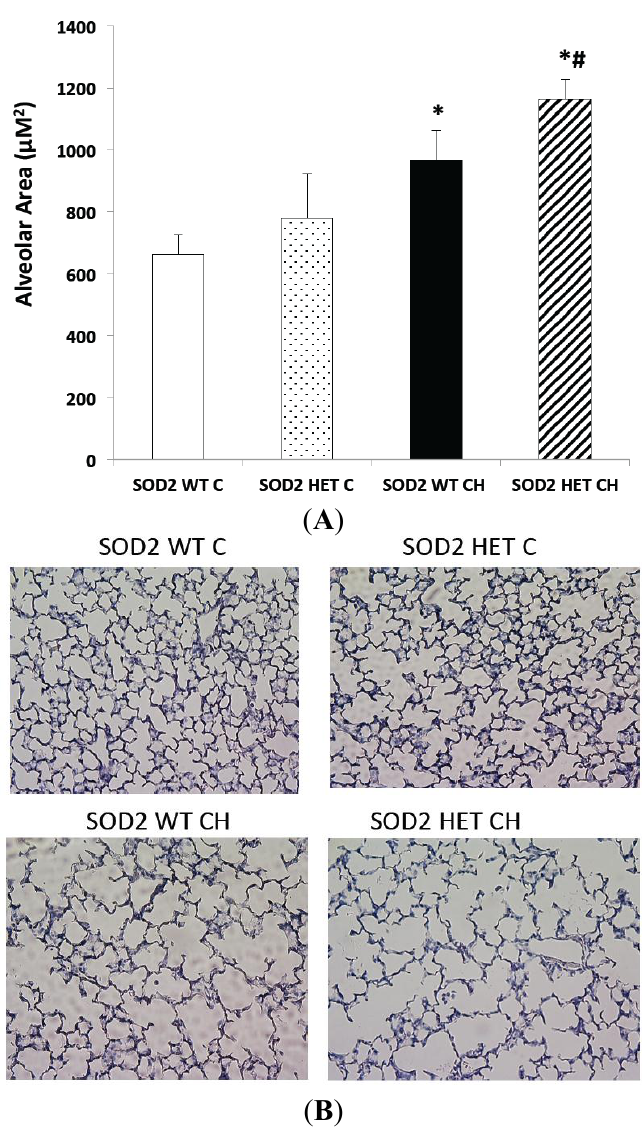
Figure 6. SOD2−/+ mice develop equivalent alveolar simplification in chronic hyperoxia (CH) relative to SOD2+/+ littermates. Neonatal mice (SOD2−/+ (HET) and isogenic SOD2+/+ (WT) littermates) were exposed to chronic hyperoxia (CH) or room air (Control (C)) from birth to 14 days of life. Mice were euthanized on day 14, and lungs were inflation fixed. ( A ) Mean alveolar area was measured on hemotoxylin-stained lung sections using Scion software. Data are shown as mean ± SEM ( n = 8–10 images per mouse with 4 mice per group; * p < 0.05 vs. SOD2 WT C mice # p < 0.05 vs. SOD2 HET Control mice); and ( B ) Representative hematoxylin-stained lung sections (20×) are